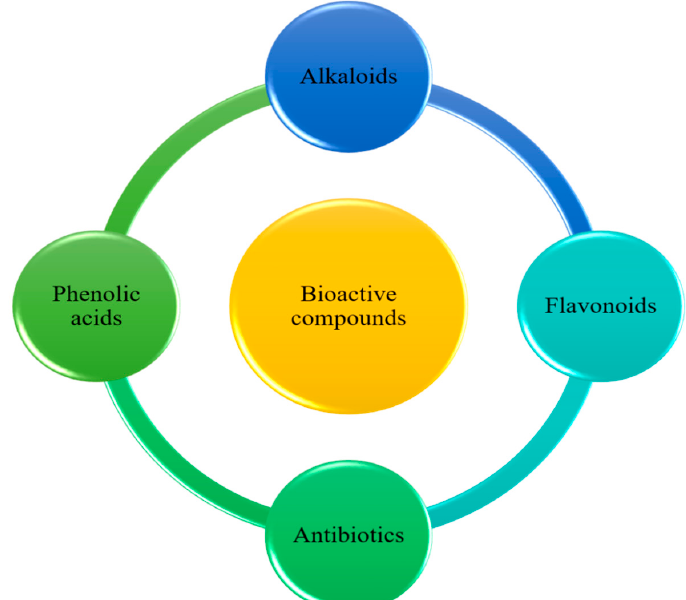
Figure 1. Bioactive compounds and their major types.